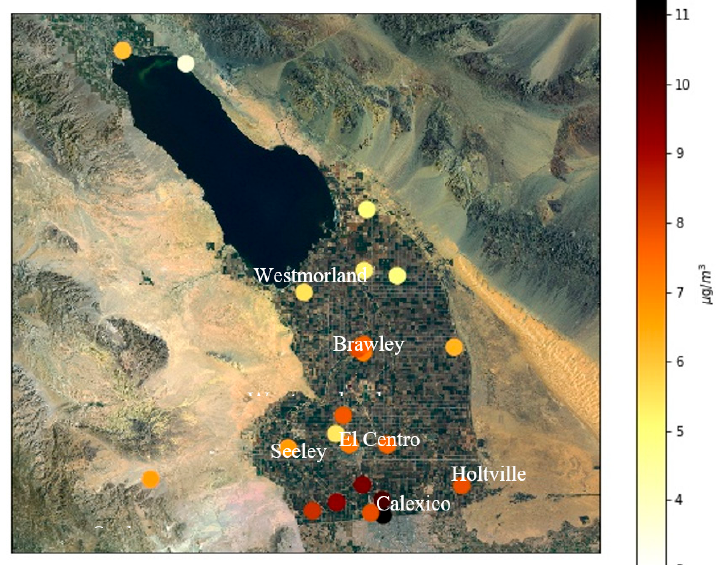
Figure 5. Annually average measured PM 2.5 concentrations at selected sensors in the IVAN system for 2017.